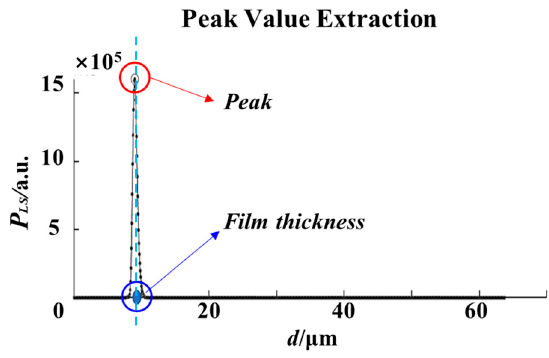
Figure 4. Peak extraction and film thickness calculation.